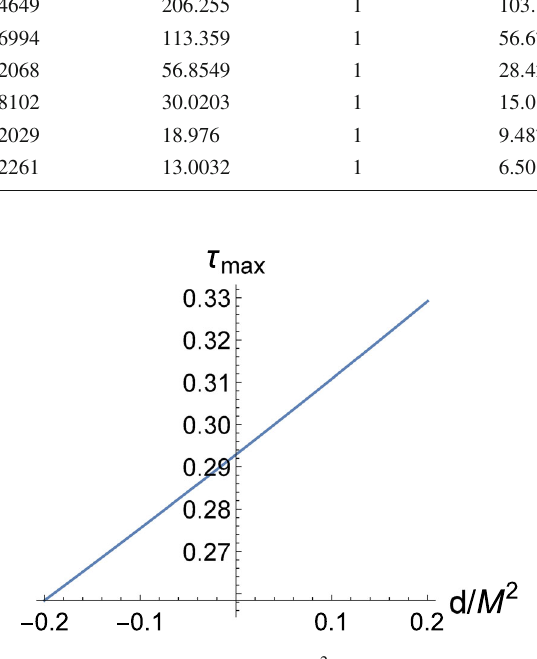
Fig. 8 The τ max as the function of d / M